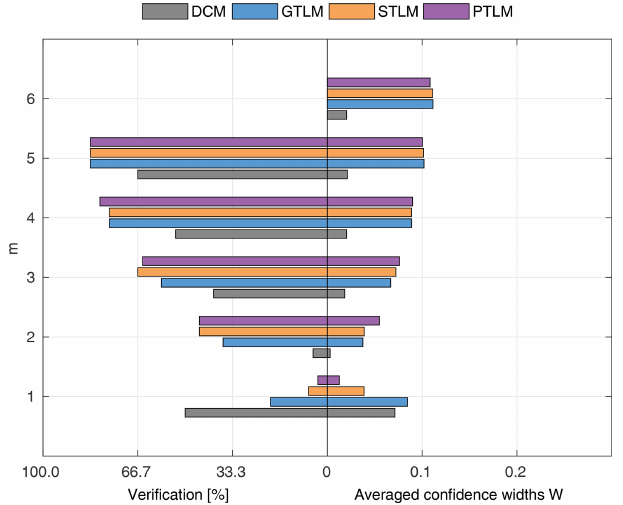
Figure 13. Percentage of the verification set ( M − m ) enclosed by confidence intervals and average width of confidence intervals for different numbers of data points for model identification ( m ); results shown for the identifiable models for Ritobacken, autumn